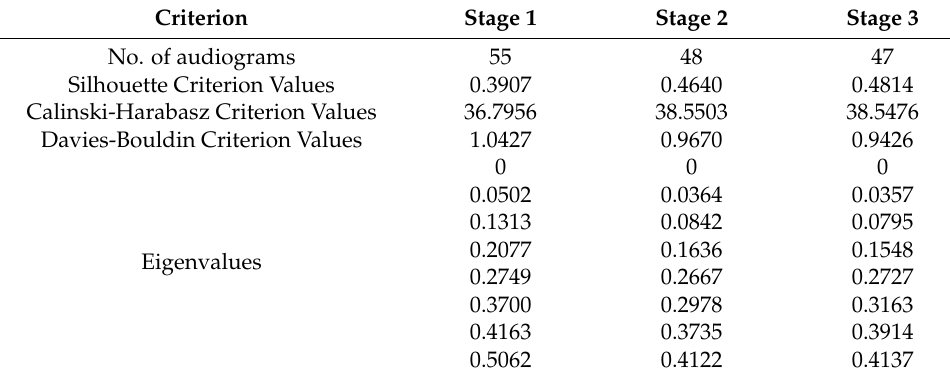
Figure 3. Silhouette plots for eight clusters. Table 3. Different clustering evaluation criteria for eight clusters. Table 3. Different clustering evaluation criteria for eight